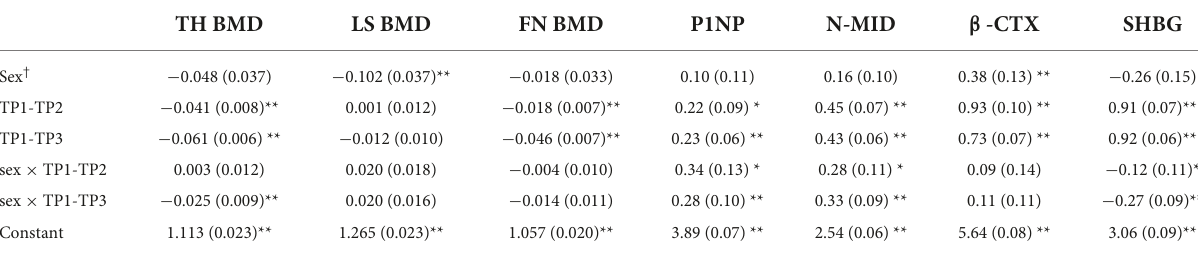
TABLE 2 Linear mixed effects in sex- and sleeve gastrectomy -related changes of bone metabolic variables and SHBG at 6 and 12 months of follow-up.